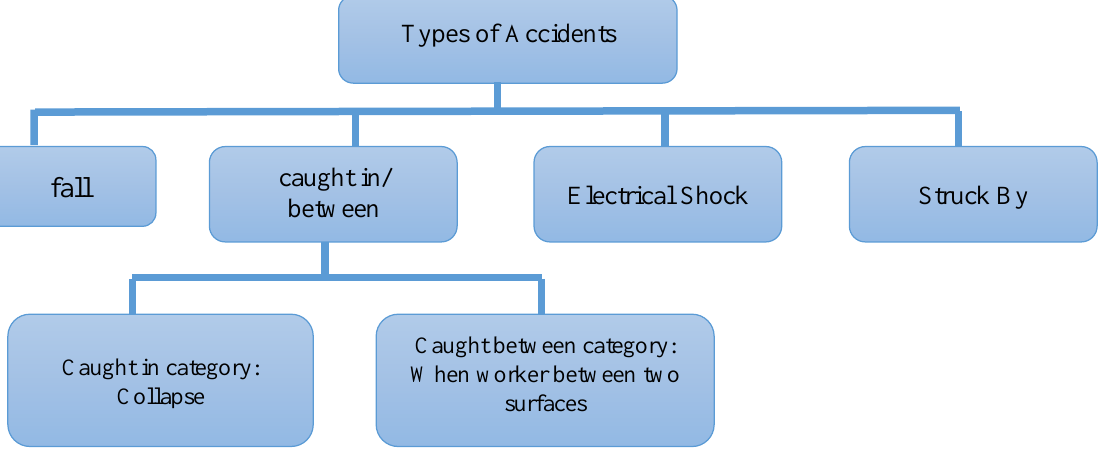
Figure 3.The main types of Accidents “Source: